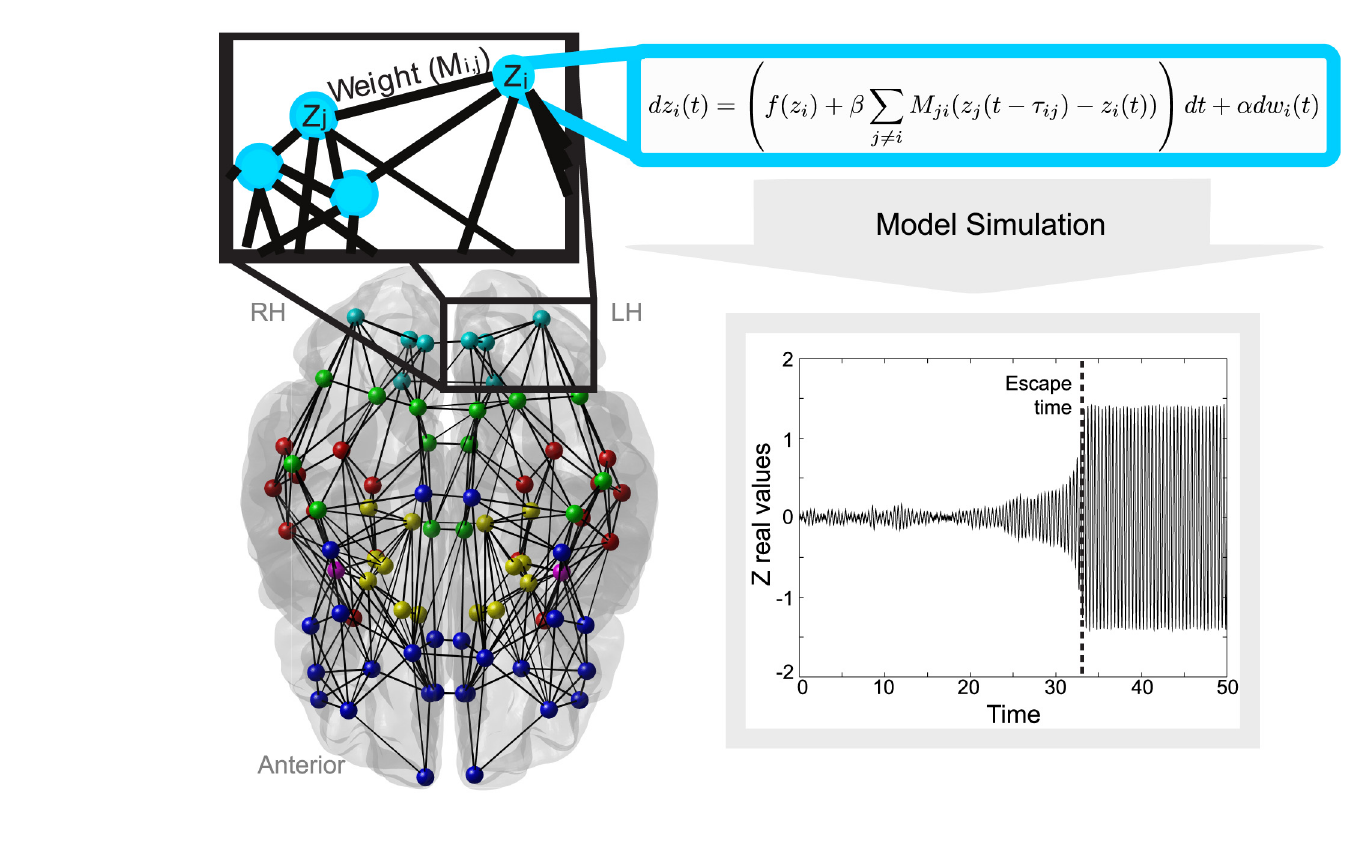
Fig 7. Connectivity, node placement and how this relates to the mathematical model. Connectivity is shown where connections exist in 60% or more of subjects, for visualisation only — all connections were included on a subject specific basis for simulations. Nodes and connections are overlaid on a 3D brain image to show the rough positioning of the nodes and the distance of connections between them. The nodes are the positions of ROI, with colours corresponding to different lobes, and the black lines show the connections between different regions. The zoomed in top left graphic shows how connections between nodes are weighted, and the blue box shows how the activity change of one node is found using the model. The bottom right figure shows a time series of the model simulation. The model begins in the background state with low amplitude oscillations and transits to a high amplitude seizure-like state at approximately t = 14, indicated by the dashed line. In this exemplary case the escape time would be taken as 14 for the node in this